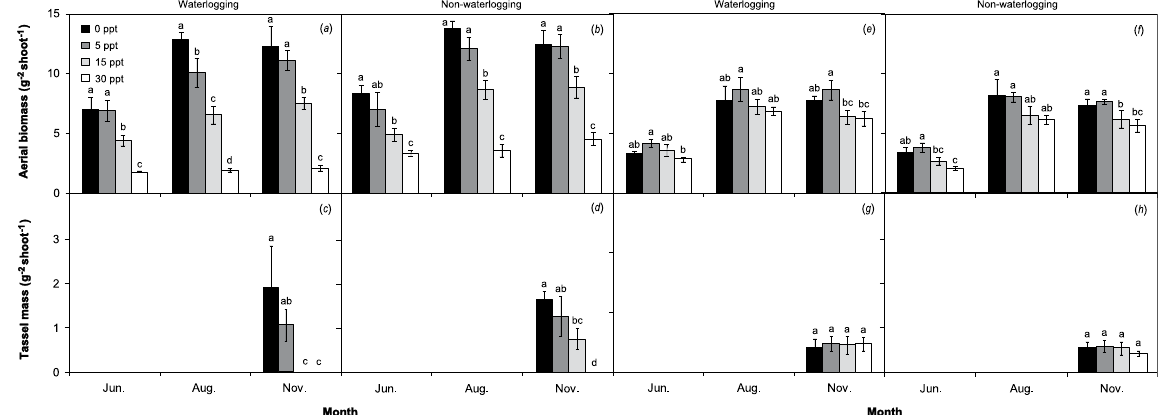
Figure 2. Seasonal variations of aerial biomass and tassel mass (mean ± S.D.) of P. australis ( a – d ) and S. alterniflora ( e – h ) under waterlogging and salinity treatments. No tassels (zero value) were recorded under 15 and 30 ppt salinity with waterlogging and 30 ppt salinity under non-waterlogging. Different letters indicate significant differences ( P < 0.05) among salinity treatments for each measurement